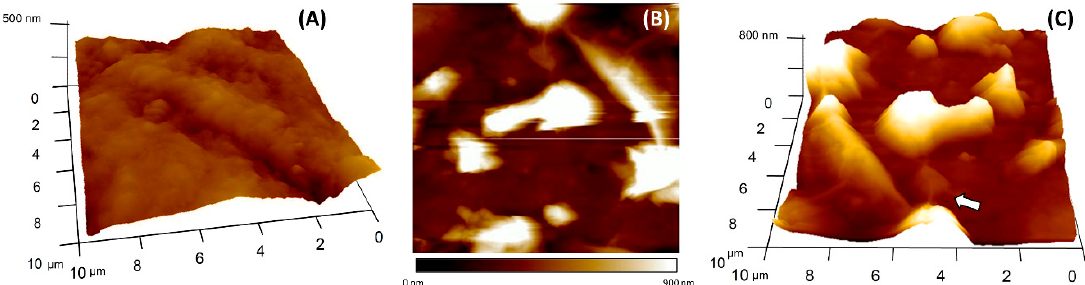
Figure 6. AFM images comparing ( A ) bare GEC electrode and ( B ) a GEC electrode modified with GO. ( C ) 3D AFM representation of the GO-GEC electrode.